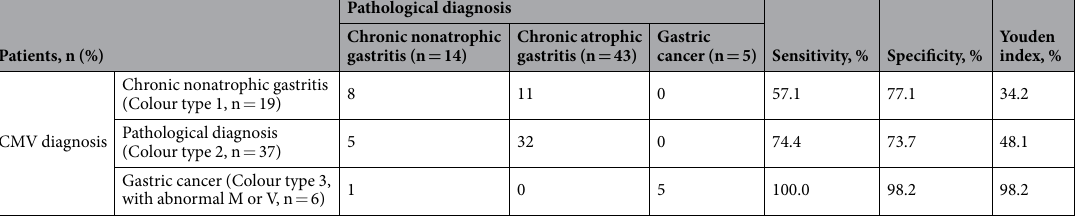
Table 3. CMV diagnosis was highly correlated with pathological diagnosis (n = 62).